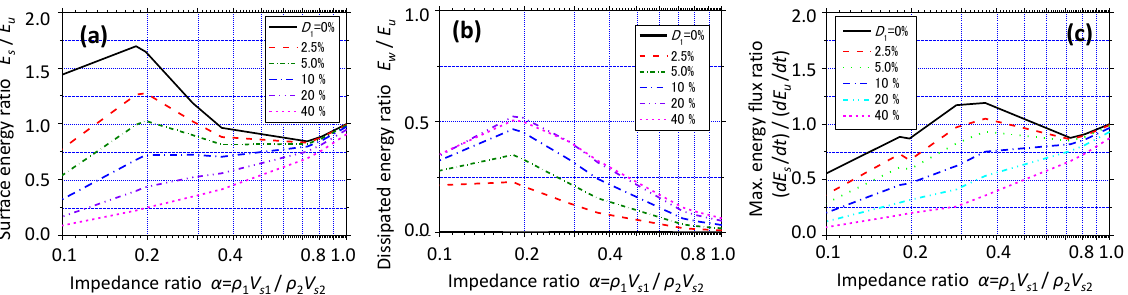
Figure 8. Energy ratio in two-layer system for irregular seismic motion versus impedance ratio. Surface energy versus base energy E s / E u ( a ), dissipated energy versus base energy E w / E u ( b ), max. surface energy flux versus max. base energy flux ( dE s / dt) /( dE u / dt) ( c ). Apart from the cumulative energy E s shown above, the energy flux defined in Equa- tion (7) is calculated in the surface layer as well as in the base layer, and the ratios of the maximum values ( dE s / dt) max /( dE u / dt) max are plotted versus the impedance ratios in Fig- ure 8c. For damping ratio D < 5%, the maximum energy flux takes a peak at an impedance